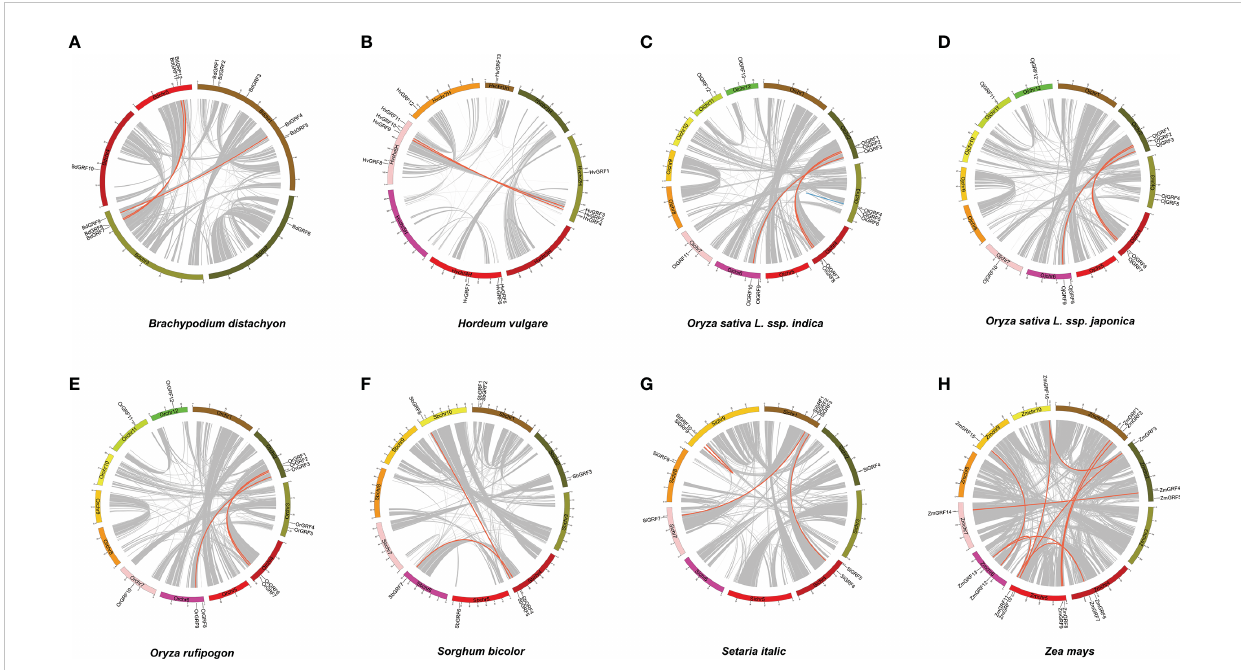
FIGURE 2 The chromosome location and duplication events of GRFs in eight Gramineae crops. The position of each GRF gene was marked using Circos software, and whole-genome duplication (WGD) or fragment duplication/tandem duplication gene pairs were connected by red/blue